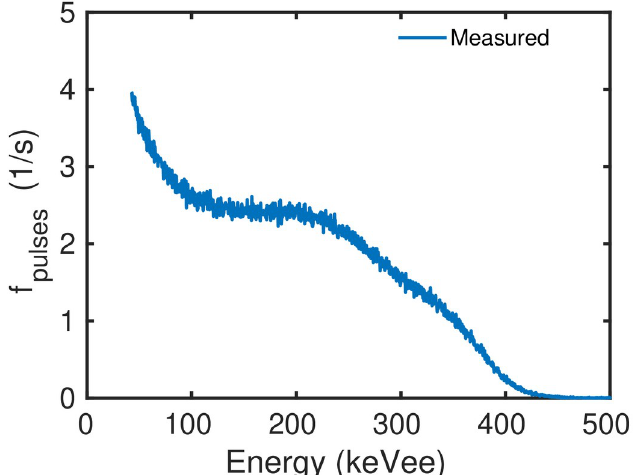
Fig 1: Response of scintillator with THIO luminophore to neutrons of energy 1.5MeV.